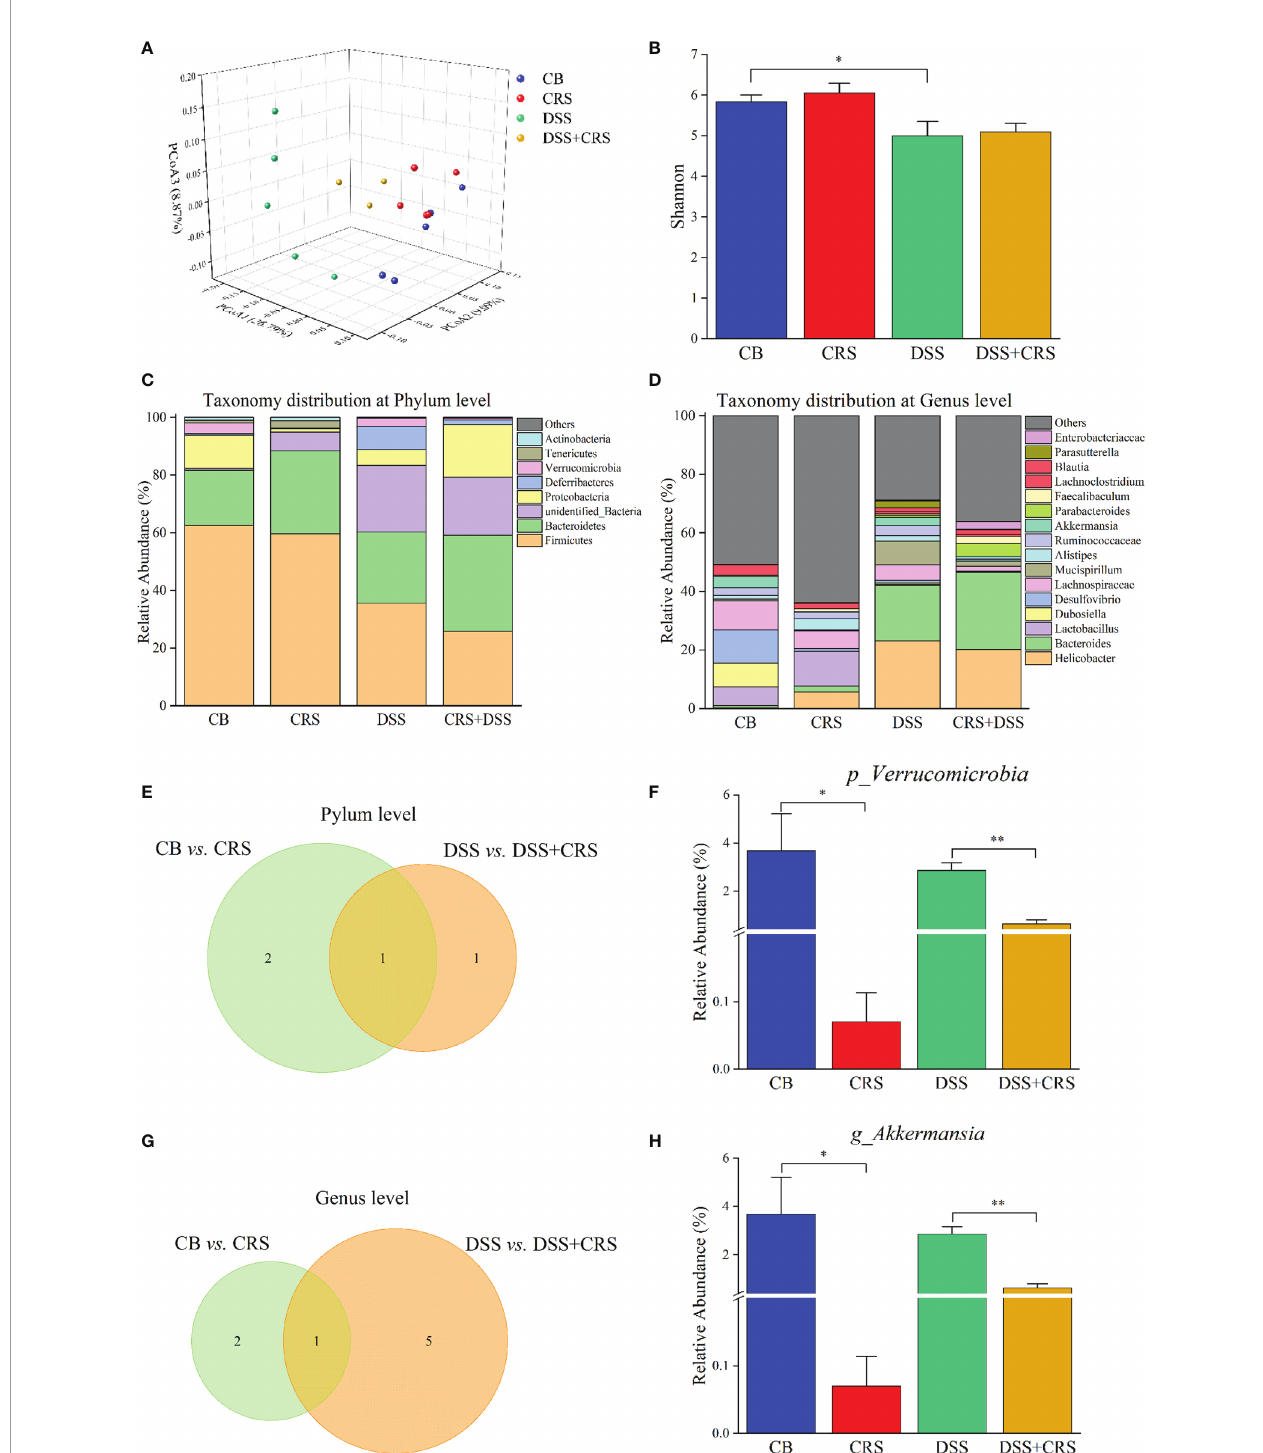
FIGURE 3 | Reduction of A. muciniphila was observed in CRS mice. (A) PCoA according to unweighted Unifrac presented a clear site-speci fi c clustering (n = 3 – 5). (B) Shannon index values among four experimental groups. (C) Microbiota composition at the phylum level. (D) Microbiota composition at the genus level. (E) Venn diagram showing only one differentially abundant species at the phylum level altered under CRS. (F) Relative abundance of Verrucomicrobia signi fi cantly decreased between groups. (G) Venn diagram showing only one differentially abundant species at the genus level altered under CRS. (H) Relative abundance of A muciniphil a had signi fi cantly decreased between different groups. *p < 0.05, **p <